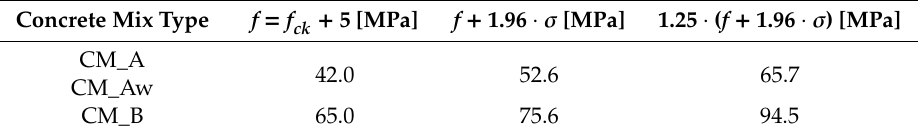
Table 6. The upper limit for “concrete